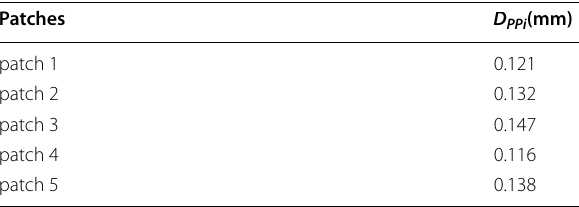
Table 2 Biggest distance from the points on each data patch to the fitted